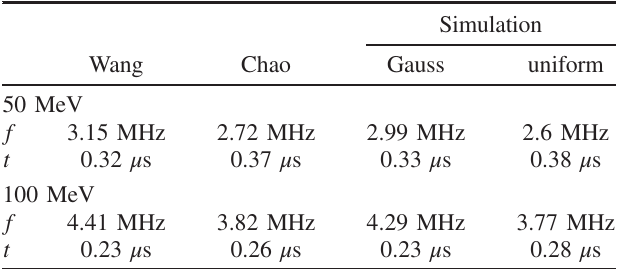
TABLE IV. Frequency of ion oscillation: theoretical and numerical results compared for H þ 2 ions. Repetition rate of the bunch is 1.3